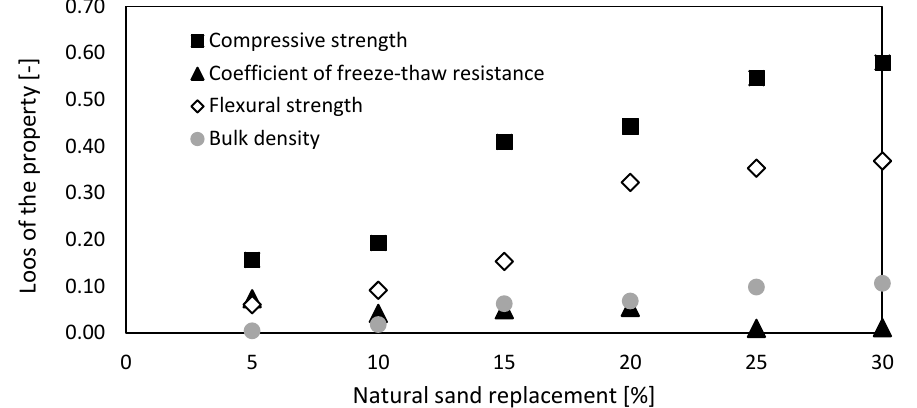
Figure 9. The loss of compressive strength and freeze-thaw resistance.